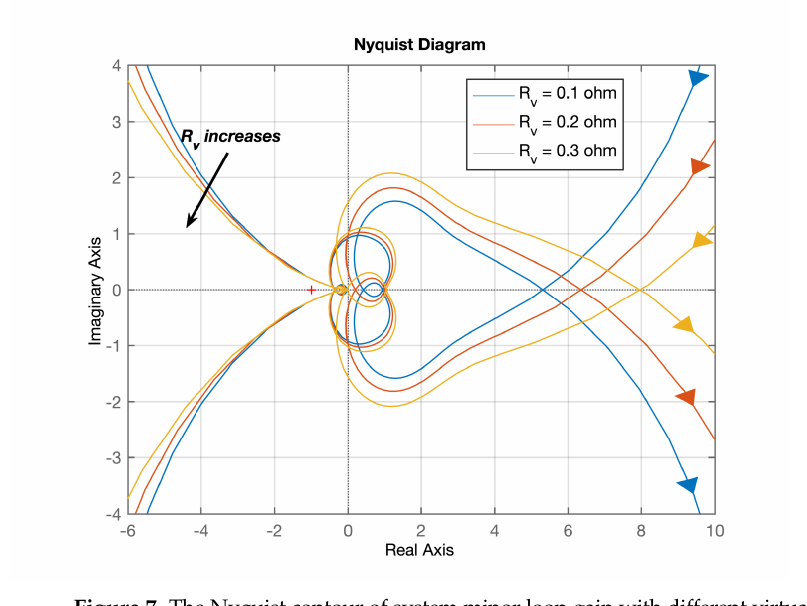
Figure 7. The Nyquist contour of system minor loop gain with different virtual resistance at rated power.